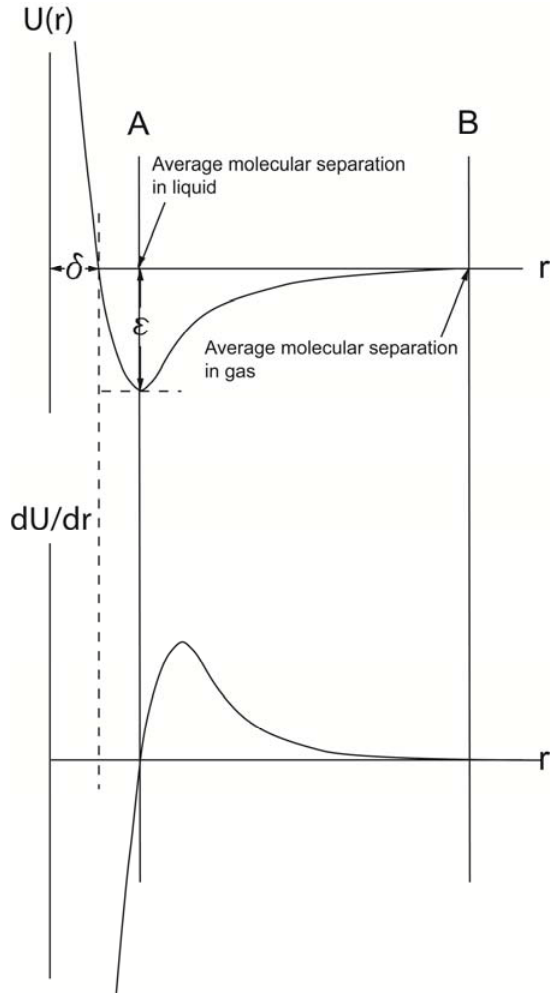
Figure 5. The upper curve is derived by combining U(r) distance, δ , these two energy levels balance each other, and an energy curve can be plotted, for which the lowest energy level is equal to ε (Lennard-Jones formula). The derivative of the energy with respect to the distance, r, between the two centers of gravities of the atoms/molecules, when plotted as a function of r, forms the force curve shown in lower graph. A comparison of the two curves reveals that when the force (dU/dr) is zero (lower graph), the U(r) value is the lowest. Thus, at this r value, the average molecular separation has occurred in the liquid (A). When the force curve reaches zero the next time (B), the average molecular separation in its gas phase has been